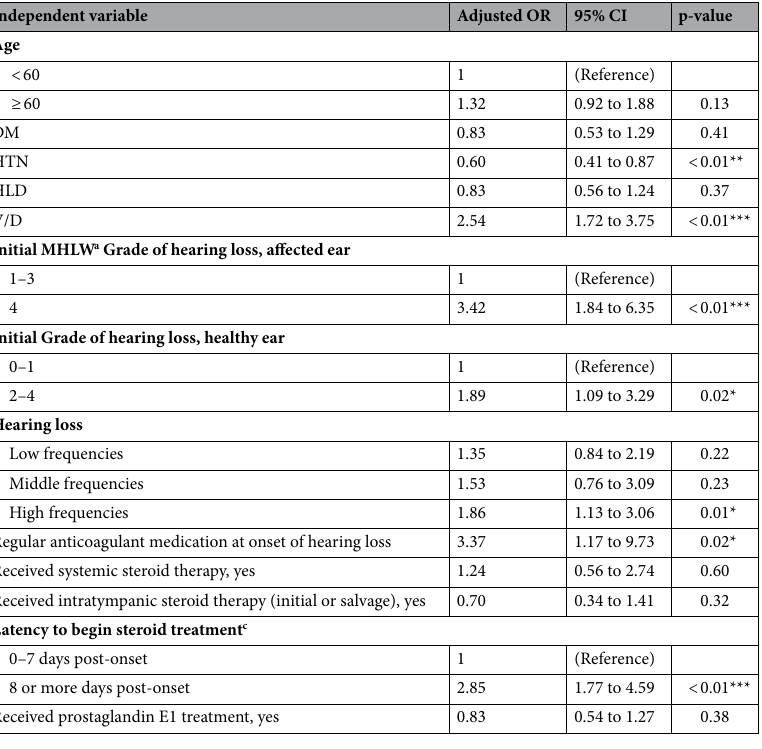
Table 5. Multivariate logistic regression model for predicting recovery from ISSNHL. Same abbreviations as in Table 1. Dependent variable = no recovery. OR, odds ratio; CI, confidence interval. *p < 0.05, ** p < 0.01, ***p < 0.001. a Criteria of the Sudden Deafness Research Committee of the Ministry of Health, Labour and